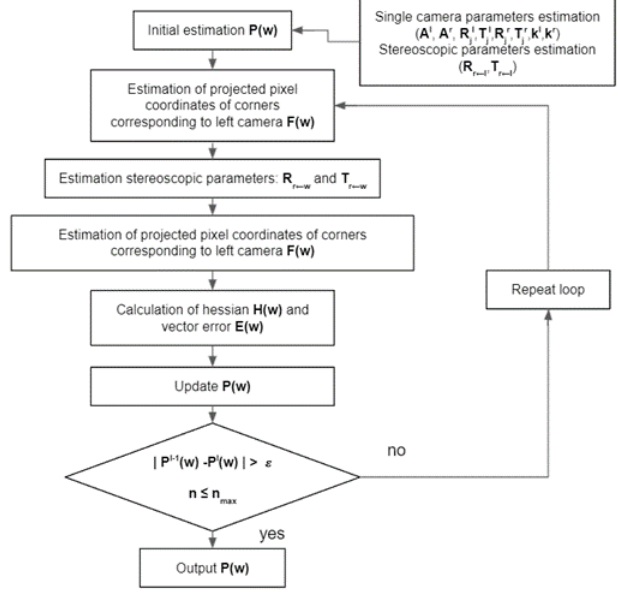
Figure A2. Iterative refinement of stereoscopic parameters.